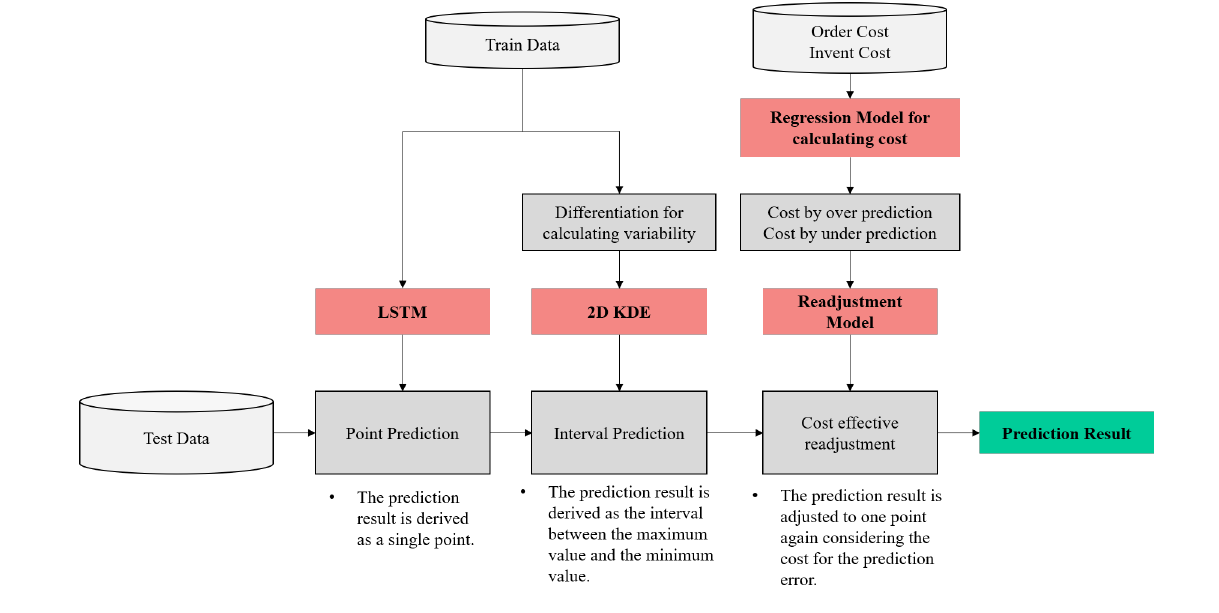
Figure 3. Overall architecture of the